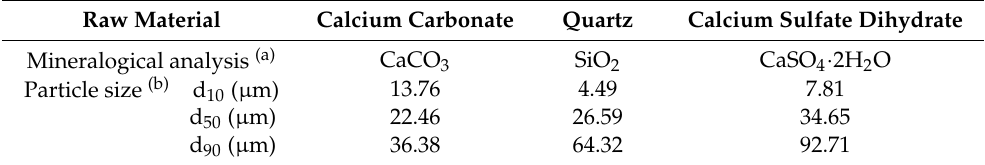
Table 2. Physical characteristics of the raw materials.